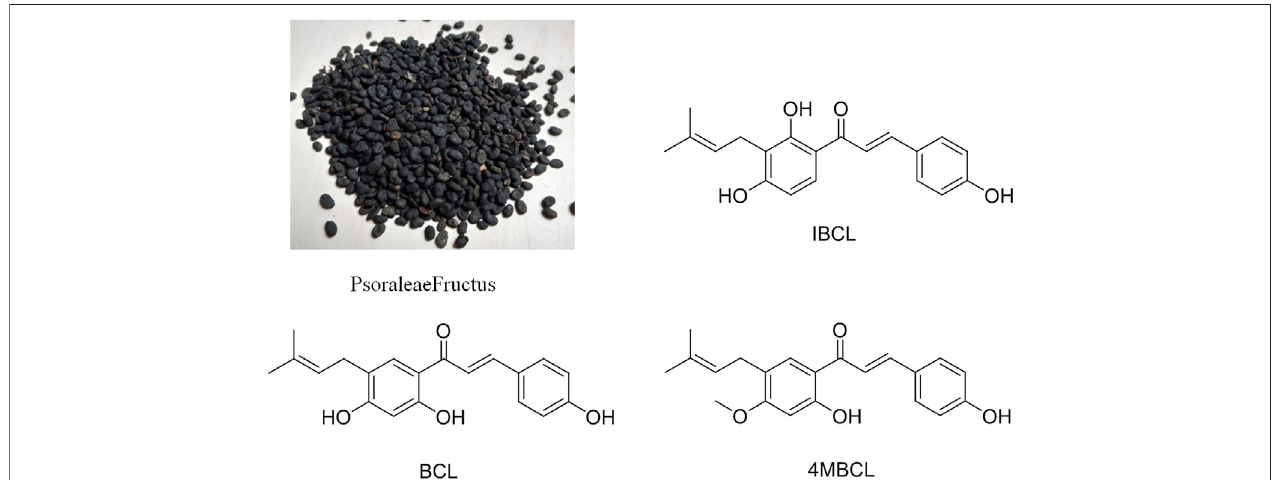
FIGURE 1 | Photograph of Psoraleae Fructus and structures of IBCL, BCL, and 4MBCL.